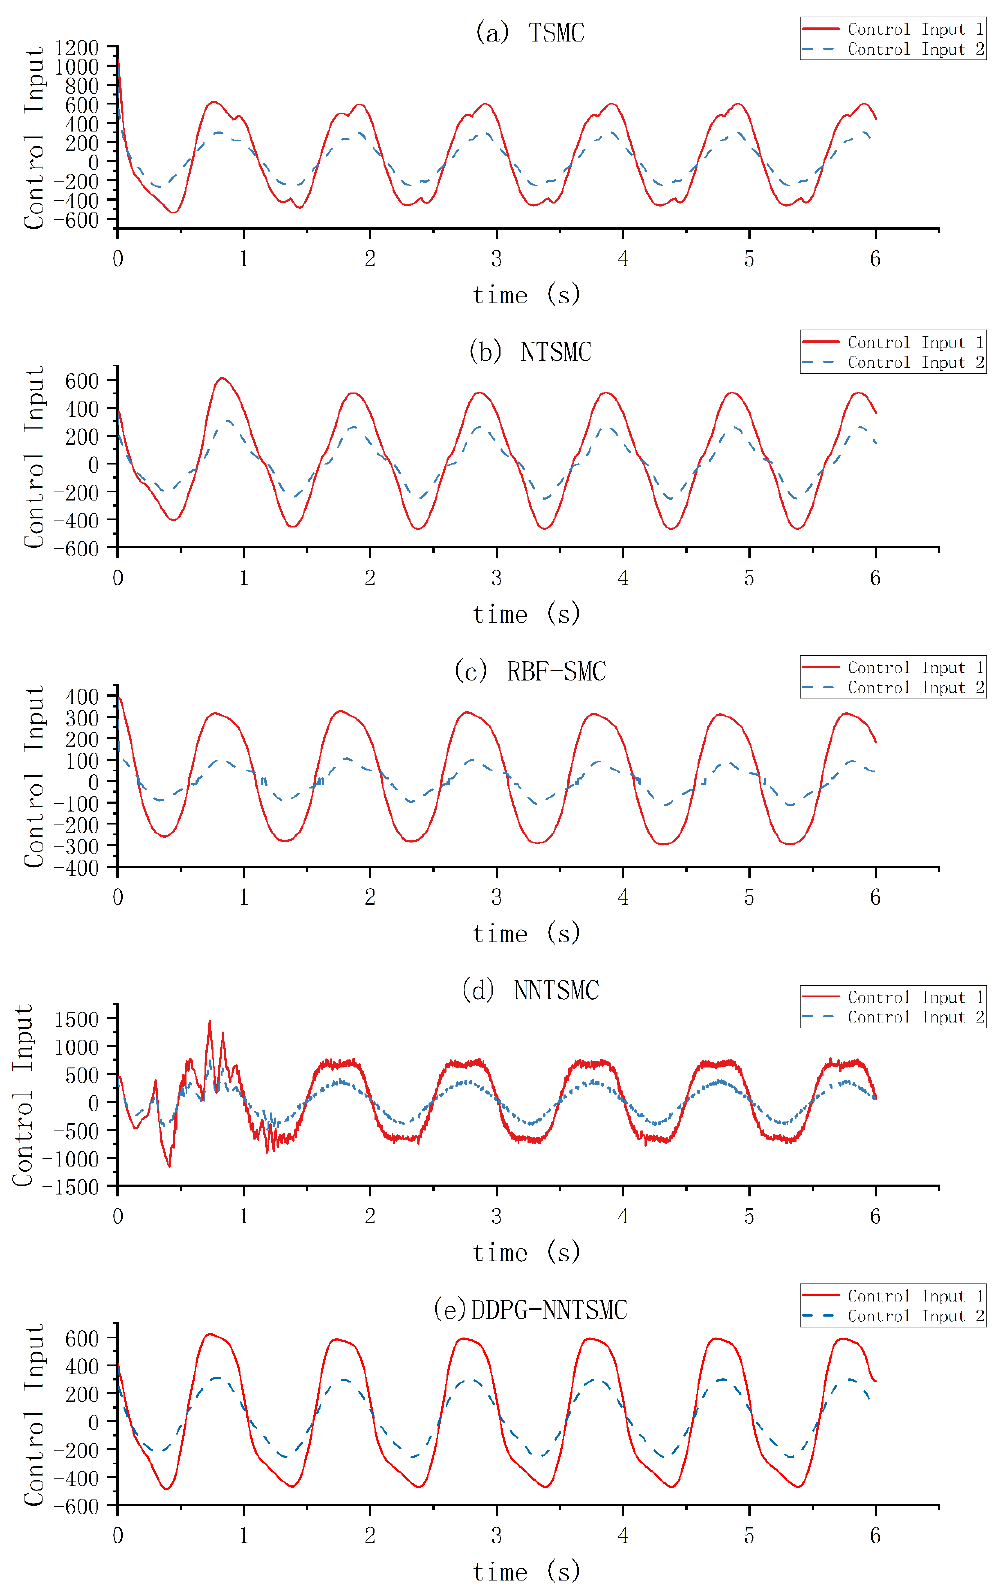
Figure 8. Control input signals of each controllers.